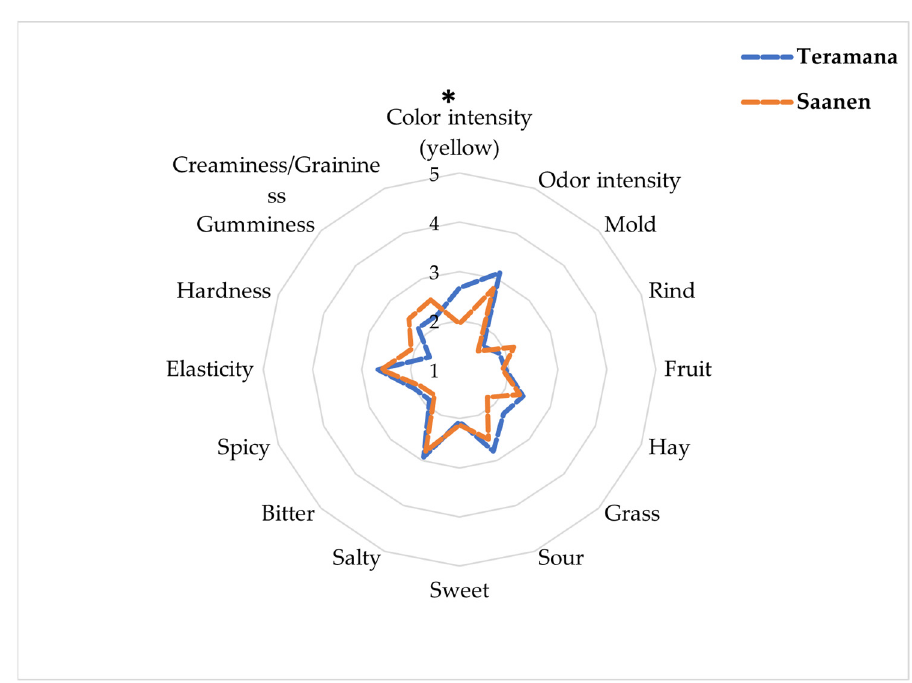
Figure 4. Graphic representation of the sensory evaluation by quantitative descriptive analysis at 60 days of ripening obtained from the milk of two goat breeds: Teramana and Saanen. *: p <